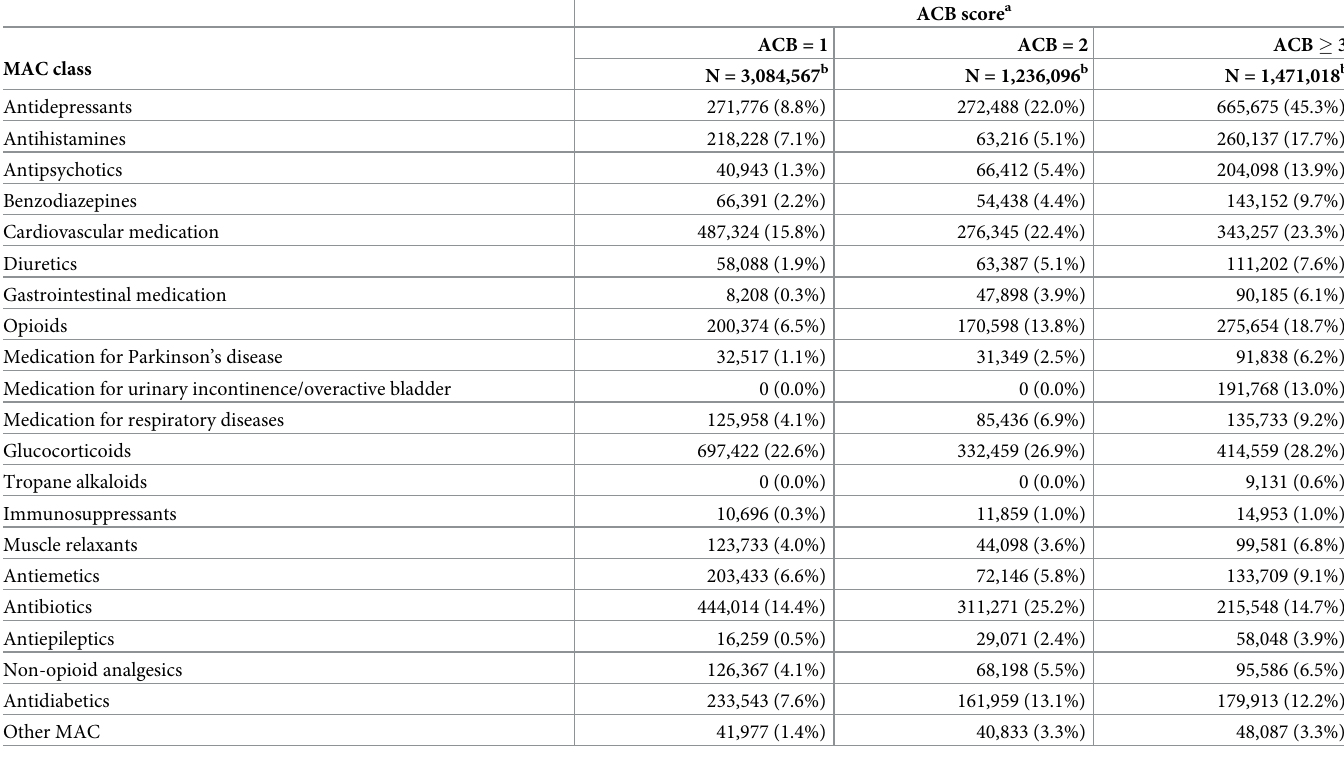
Table 2. Prevalence of use of medications with anticholinergic activity (MACs) in persons with anticholinergic burden measured through the anticholinergic cogni- tive burden (ACB) scale during the observation period